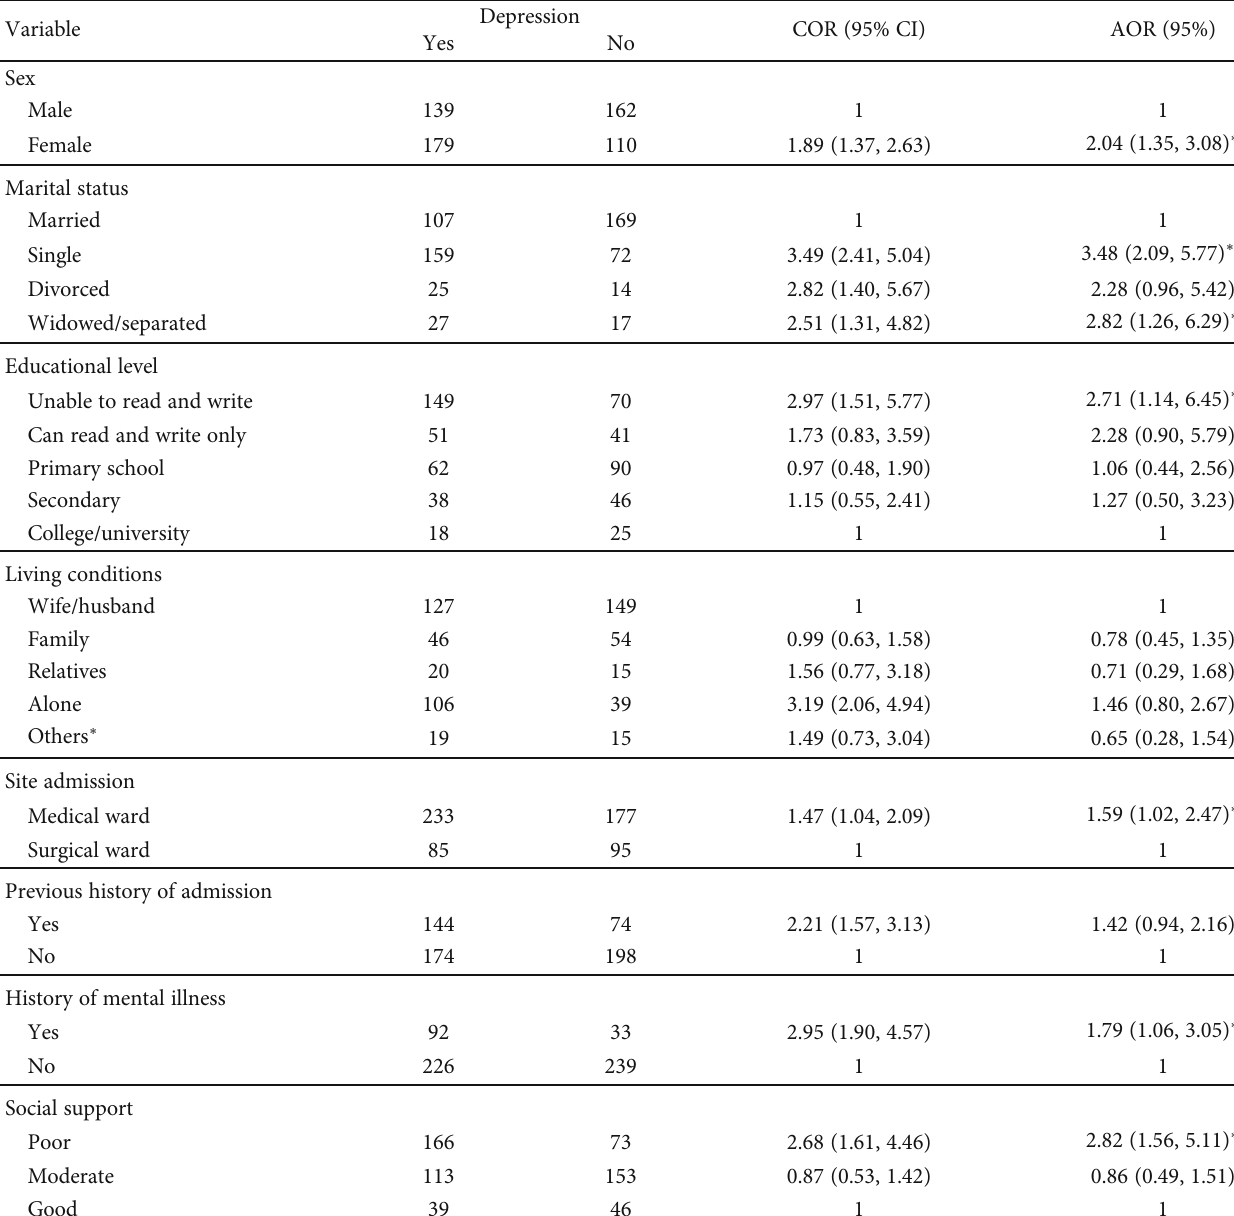
Table 4: Bivariate and multivariate analyses among admitted patients in medical and surgical wards at SPHMMC, Addis Ababa, Ethiopia ( n = 590